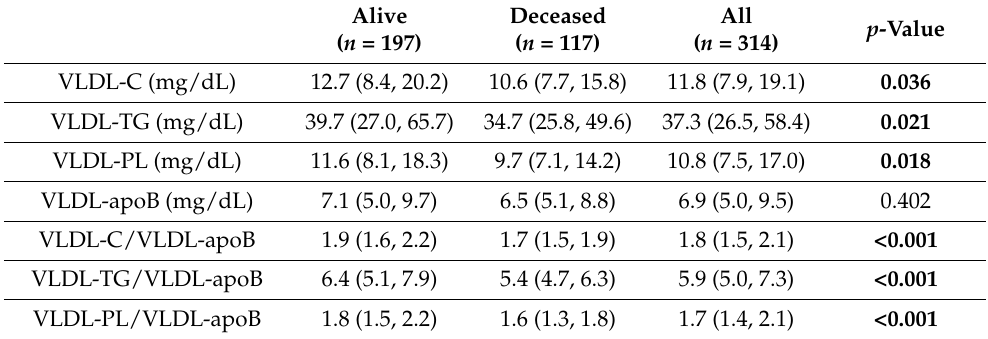
Table 2. Differences in serum levels and lipid content of VLDL parameters in AHF